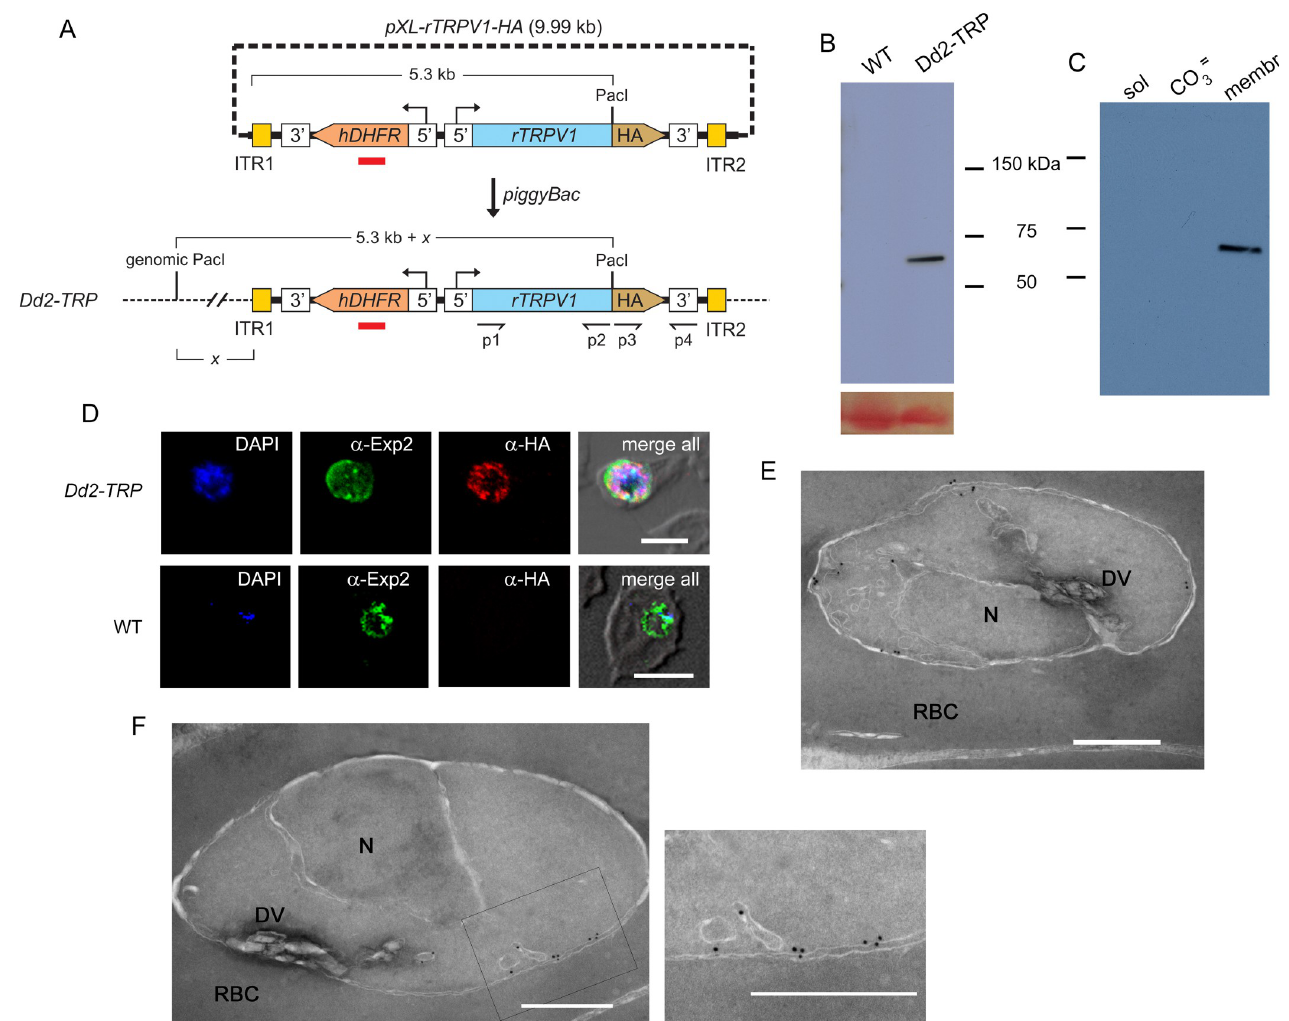
Fig 1. Expression and localization of the rat TRPV1 channel protein in P . falciparum . (A) Schematic showing piggyBac transfection strategy for stable expression of the rat trpv1 gene product ( rTRPV1 ) with a C-terminal HA epitope tag upon integration in the Dd2- TRP parasite clone. This strategy integrates the sequence between two inverted terminal repeats (ITR1 and ITR2) into the genome at one or more sites; this region includes the hDHFR selection cassette. Primers to confirm retention of the channel gene and the site recognized by the Southern blotting probe (red bar) are shown. (B) Immunoblot of total cell lysates from wild-type (WT) and Dd2- TRP lines, probed with mouse anti-HA tag antibody. Ponceau S staining of hemoglobin on the membrane is shown at the bottom as a loading control. (C) Anti-HA immunoblot of match-loaded samples from Dd2- TRP after hypotonic lysis and fractionation into soluble, carbonate extractable, and integral membrane pools (sol, CO 3 = , and membr, respectively). The expressed TRPV1 protein is integral to parasite membranes. (D) Immunofluorescence antibody (IFA) images of trophozoite-infected cells from indicated parasites, showing labeling with mouse anti-EXP2 and rabbit anti-HA antibodies. TRPV1 localizes within the intracellular parasite and is not exported into the host cell. Scale bar, 5 μ m. (E, F) Immunoelectron microscopy images using rabbit anti-HA and a secondary goat anti-rabbit antibody conjugated with 18 nm colloidal gold particles, suggesting TRPV1 trafficking via the parasite ER to the parasite plasma membrane. N, parasite nucleus; DV, digestive vacuole; RBC, red blood cell cytosol; box in panel F, area of zoom in image to right. Scale bars, 500 nm. parental wild-type line (Fig 1B). Hypotonic lysis and treatment of membranes with Na CO 2 3 revealed that the recognized protein is not soluble or released by alkaline treatment, establish- ing that TRPV1 is expressed exclusively as an integral membrane protein in the parasite (Fig 1C). Indirect immunofluorescence microscopy using anti-HA antibodies recognized the chan- nel protein, excluded export into the host erythrocyte, and suggested localization to the intra- cellular parasite’s plasma membrane (Fig 1D). Immunoelectron microscopy further supported